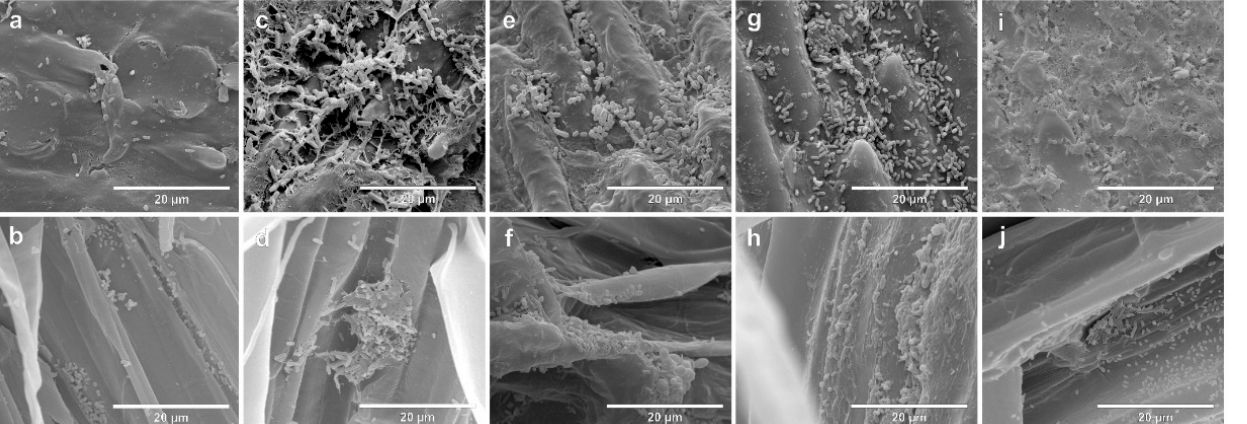
Figure 2. Scanning electron micrographs of the seeds and rootlets of Megathyrsus maximus cultivar Massai, colonized by Azospirillum brasilense (CNPSo 2083 + CNPSo 2084) , Bacillus subtillis (CNPSo 2657), Pseudomonas fluorescens (CNPSo 2719), or Rhizobium tropici (CNPSo 103), after seven days of growth. Non-inoculated seeds ( a ) and rootlets ( b ); seeds ( c ) and rootlets ( d ) of plants inoculated with A. brasilense ; seeds ( e ) and rootlets ( f ) of plants inoculated with B. subtilis ; seeds ( g ) and rootlets ( h ) of plants inoculated with P. fluorescens ; seeds ( i ) and rootlets ( j ) of plants inoculated with R. tropici .